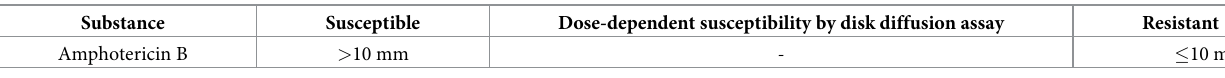
Table 1. Interpretation criteria for fungal susceptibility to amphotericin B by disk diffusion assay.